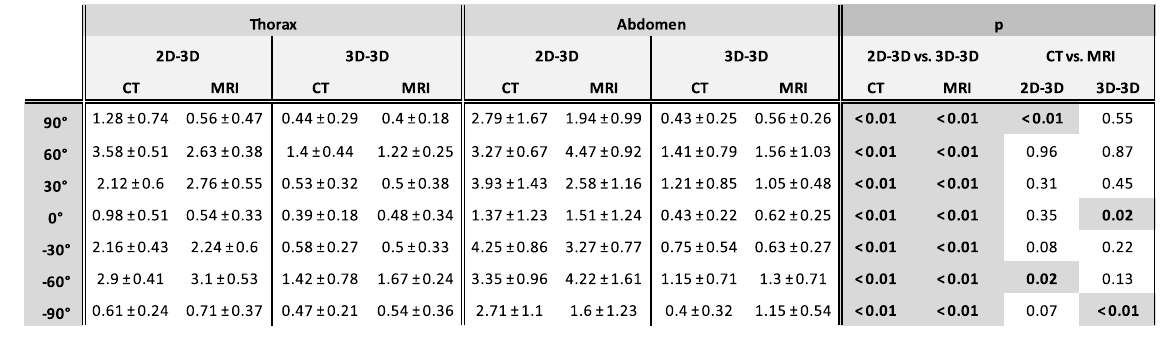
Results for seven different c-arm angulations and both imaging modalities in the thorax and the abdomen are given. For each angulation, the mean±standard deviation of all measurements along the vessel ’ s course was calculated. Significance was accepted for p <0.05; significant differences are underscored in dark grey. Overall, 3D-3D registration was more accurate than 2D-3D registration. Furthermore, a decrease in registration accuracy was observed for c-arm angulations of 30° to 60° and − 30° to −